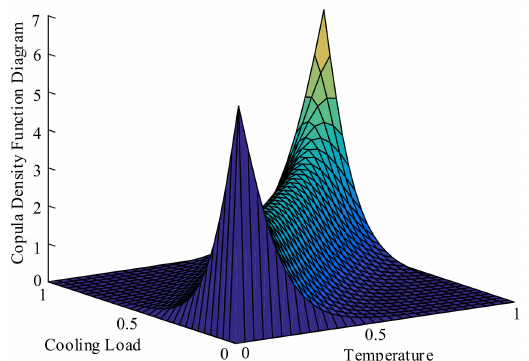
Figure 5. Copula density function diagram of cooling load and temperature.